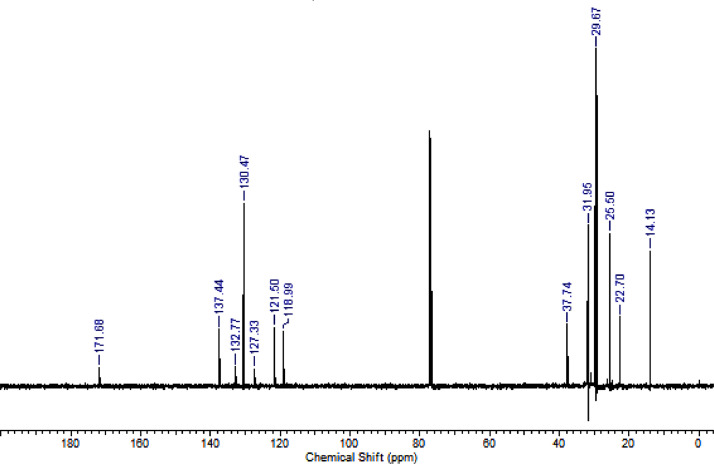
13C NMR (CDCl3, 100 MHz) spectrum of compound 11a.